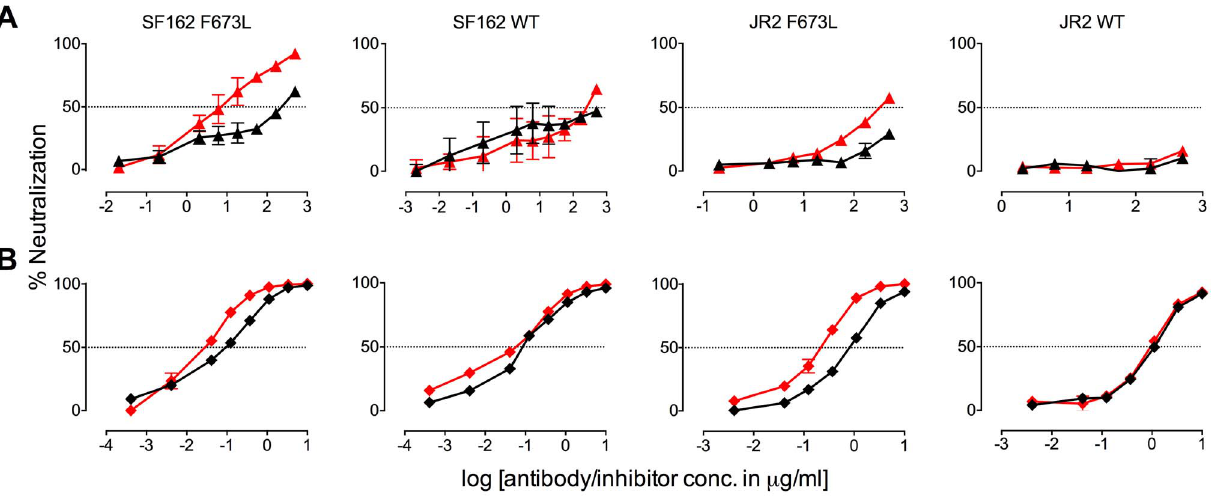
Figure 6. Presence of 10E8 alters sensitivity of HIV-1 to post-attachment fusion inhibitors. The presence (red) or absence (black) of 10E8 at 10 m g/ml or the IC 50 for F673L mutants and wild type viruses, respectively, affects the neutralization sensitivity of cognate virus to ( A ) DN9 IgG and ( B ) C34 peptide.